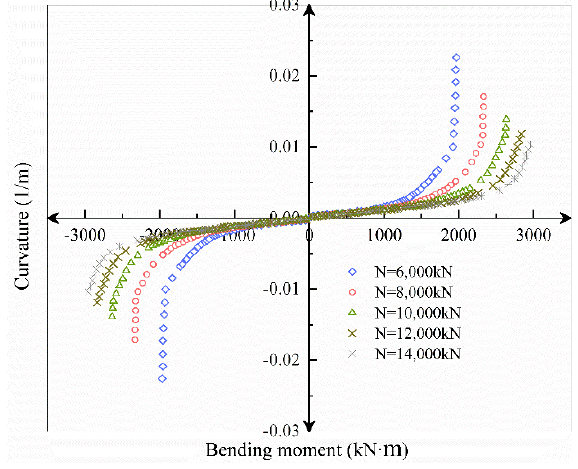
Figure 16. M– ϕ relationship curve under different axial forces. Figure 16. M– φ relationship curve under different axial forces.